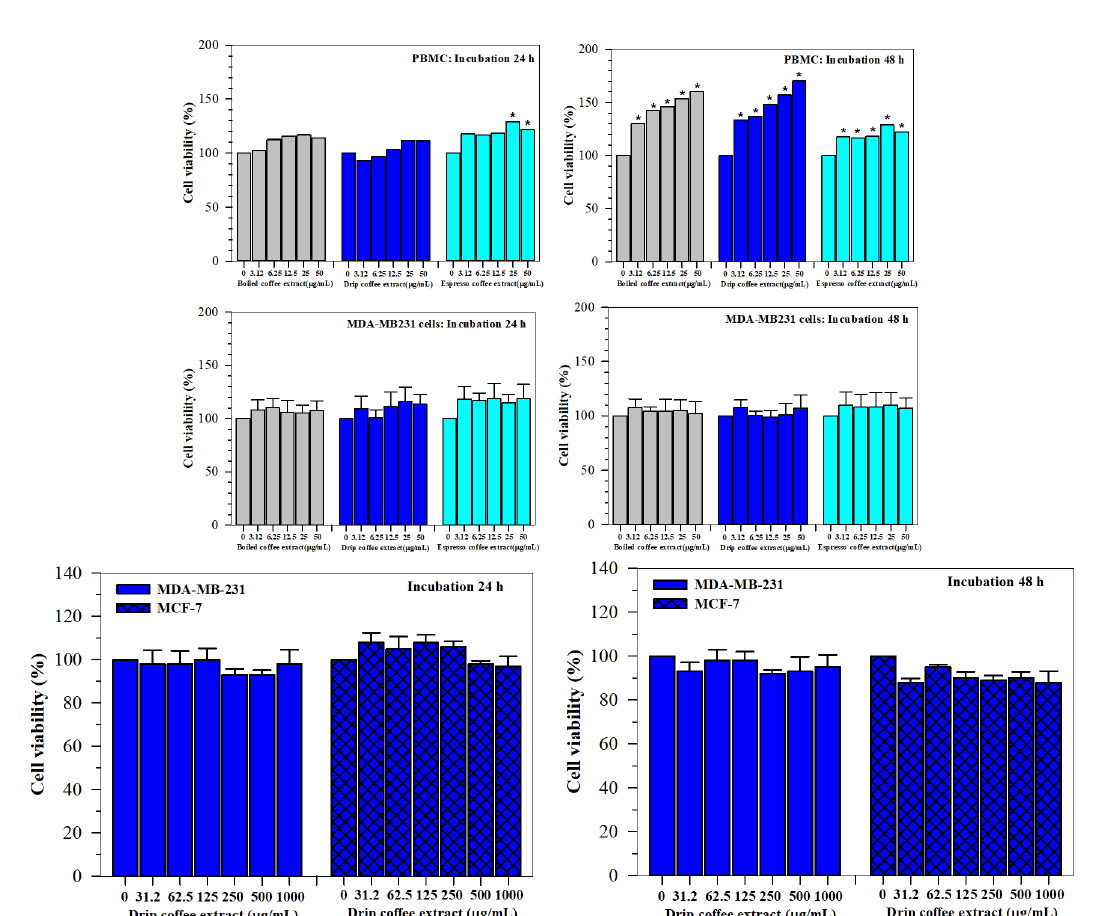
Figure 6. Viability of PBMC, MDA-MB-231 and MCF-7 cells treated with roasted coffee extracts. Normal human peripheral blood mononuclear cells (PBMC) and human breast cancer (MDA-MB-231) cell lines were treated with boiled, drip